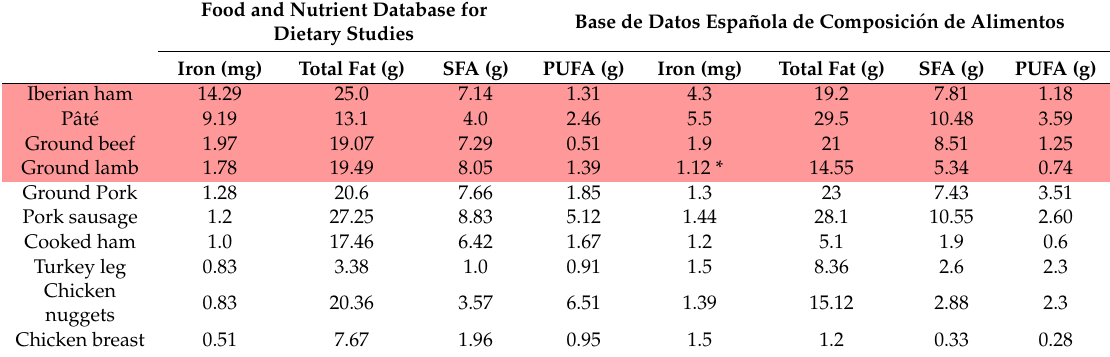
Red meat and meat-products; White meat and meat-products. *mostly suckling lamb; PUFA, polyunsaturated fatty acids; SFA, saturated fatty acids; Source: Food and Nutrient Database for Dietary Studies (FNDDS) and Base de Datos Española de Composición de Alimentos (BEDCA). Compositions are expressed either per 100 g edible portion of different meat. In addition, it has to be pointed out that there are no unique and unified criteria distinguishing